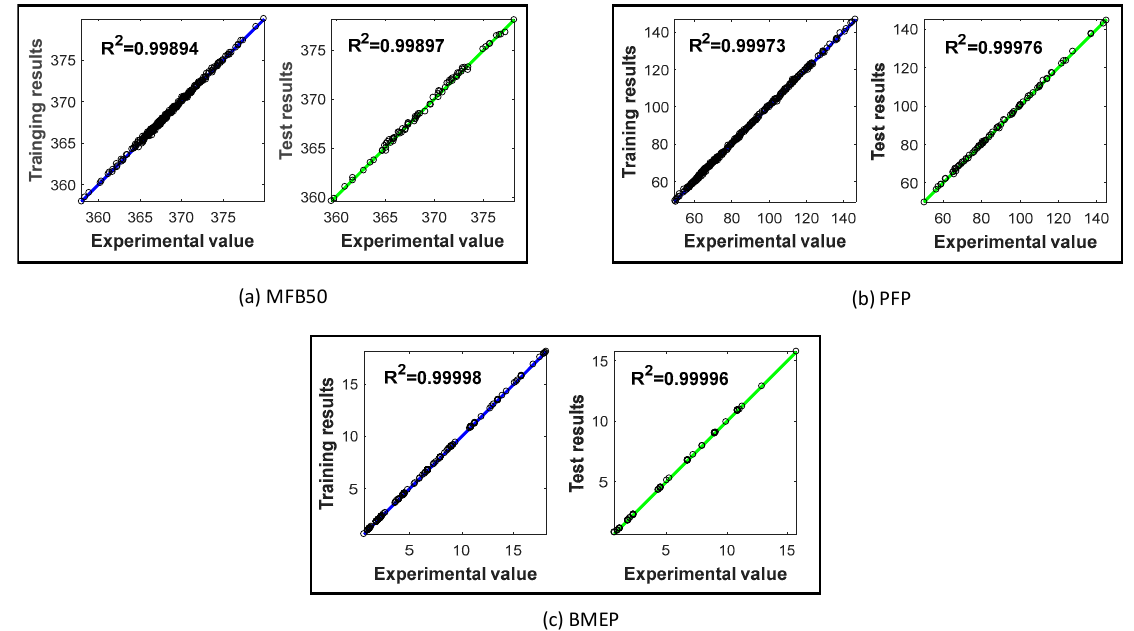
Figure A10. Comparison of the experimental and ANN fitting results for the direct estimation of MFB50 ( a ), PFP ( b ) and BMEP ( c ).